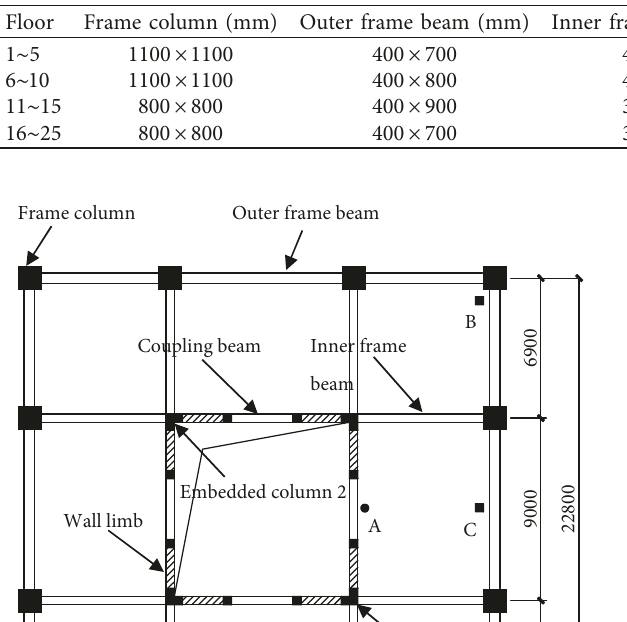
Table 2: Component section of prototype structure.